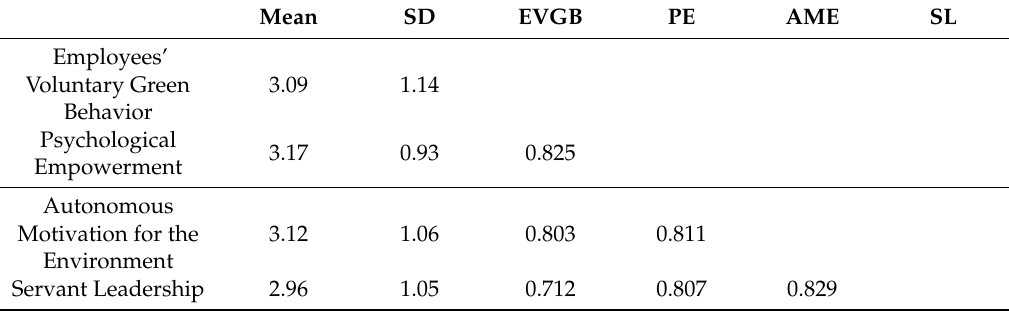
Table 3. Standard deviation and discriminant validity through HTMT